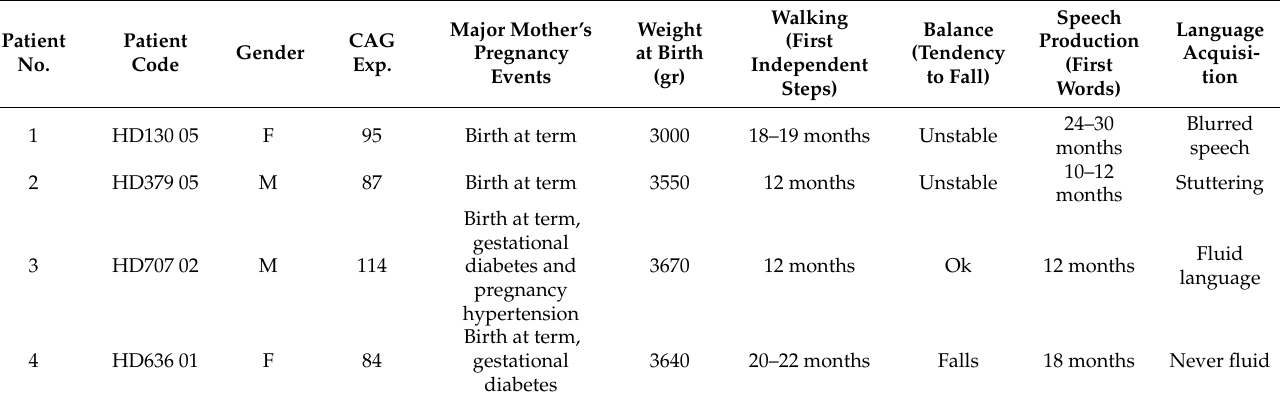
Table 2. First developmental steps.